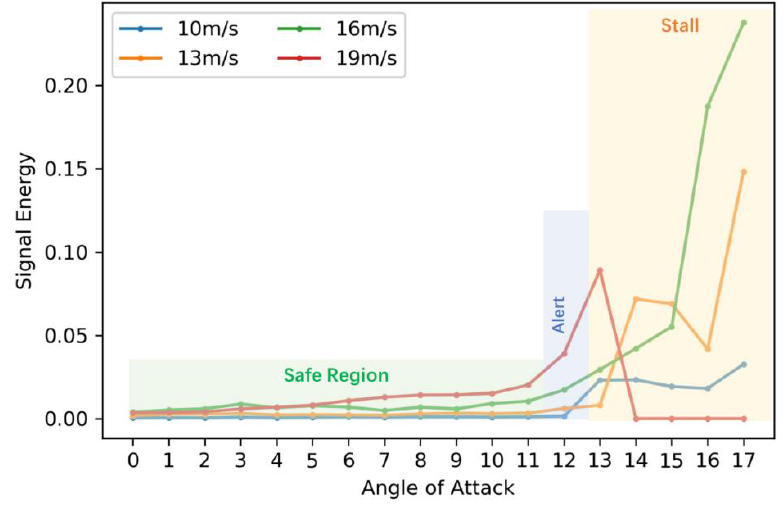
Figure 4. Signal energy under various flight states.